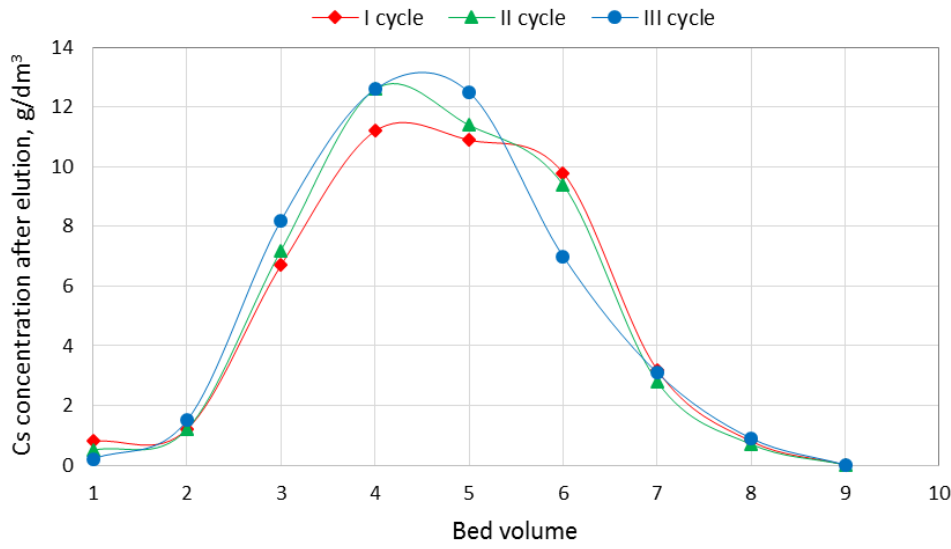
Figure 6. Characteristics of CT169 during elution. Table 5. Parameters for cesium ion sorption—CT169.